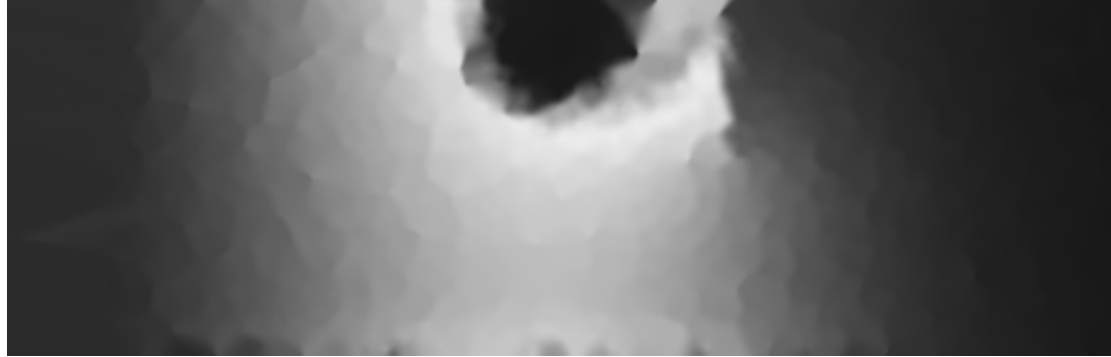
Figure 14. Heat map generated by run (1)